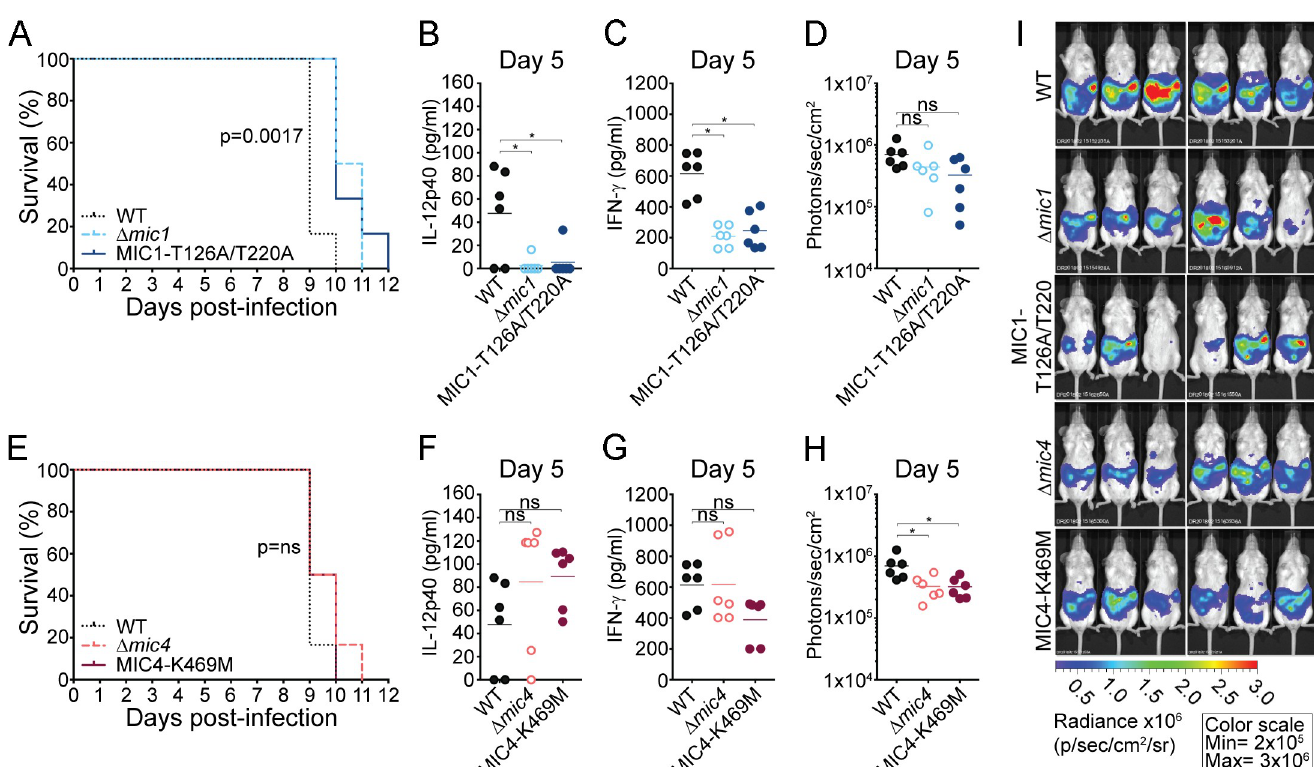
Fig 6. MIC1 lectin activity, but not MIC4, contributes to virulence in mice during in vivo infection with T . gondii . CD-1 mice were infected intraperitoneally with RH engineered strains of T . gondii at an infectious dose of 50 tachyzoites/mouse (n = 6). Mortality kinetics of mice infected with (A) WT, Δ mic1 and Δ mic1 :: MIC1-T126A/T220A strains or (E) WT, Δ mic4 and Δ mic4 ::MIC4-K469M parasites. At day 5 post-infection the sera were collected for measuring systemic (B and F) IL-12p40 and (C and G) IFN- γ . (D, H and I) Bioluminescent detection in photons/sec/cm 2 shows parasite burden 5 days post-infection. Data are expressed as mean ± S.D. and significance was calculated with ANOVA followed by Bonferroni’s multiple comparisons test. � p < 0.05. Data are representative of three independent experiments, with total n =